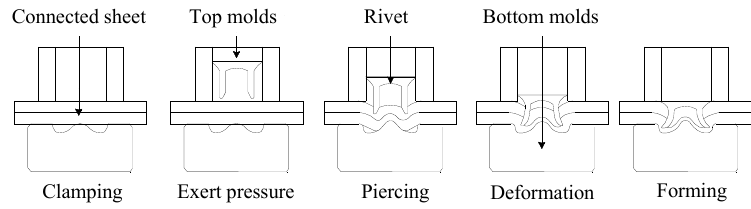
Figure 1. Prototyping mechanism of an SPR joint [3].